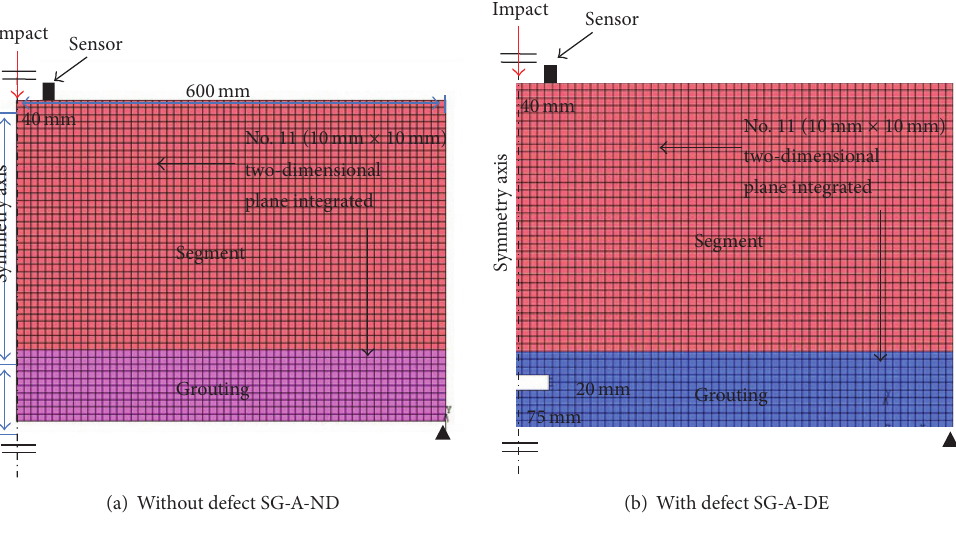
Figure 7: SG finite element models.